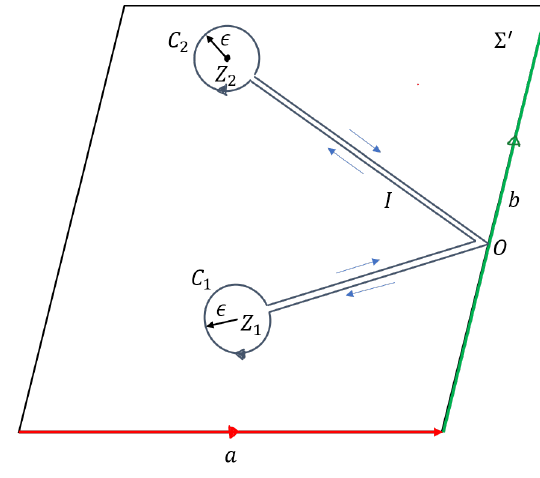
Figure 4 . The region Σ 0 obtained by cutting Σ through the curves C 1 , C 2 and I . The path obtained by the union of the curves C 1 , I , C 2 and I − 1 is denoted by